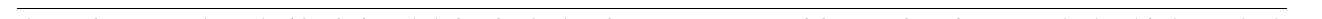
Figure 3 | LncHIFCAR is required for the hypoxia-induced activation of HIF-1 target genes and the HIF-1-dependent transactivation. ( a ) The RNA levels of HIF1A and HIF-1 target genes in HeLa cells transfected with vector, LncHIFCAR - or RMRP-expressing plasmids for 48h measured by qRT–PCR. ( b ) The RNA levels of HIF-1 target genes in HeLa cells transfected with different amount of the LncHIFCAR -expressing plasmid measured by qRT–PCR. ( c ) HIF-1 target genes expression in HeLa cells transfected with the indicated siRNAs. Twenty-four hours after transfection, the cells were treated by CoCl 2 for 16h, followed by qRT–PCR analysis with normalization against RPLP0 level. ( d ) qRT–PCR analysis of HIF-1 target genes expression (normalized to RPLP0 ) in siRNA-transfected SAS cells under 24h treatment of normoxia or hypoxia. ( e ) The expression of LncHIFCAR and HIF-1 target genes in tumour